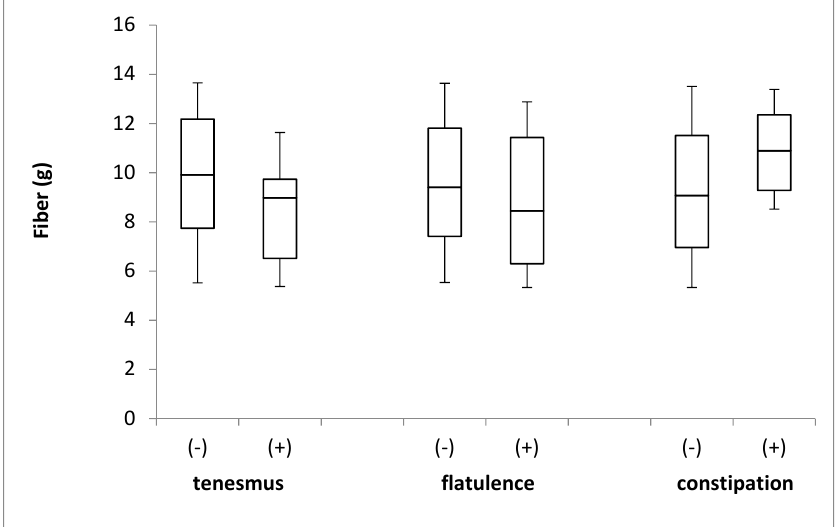
Figure 8. The box plots of fiber intake in groups of individuals stratified by the analyzed symptoms of tenesmus, flatulence and constipation. (-) symptom not declared; (+) symptom declared.